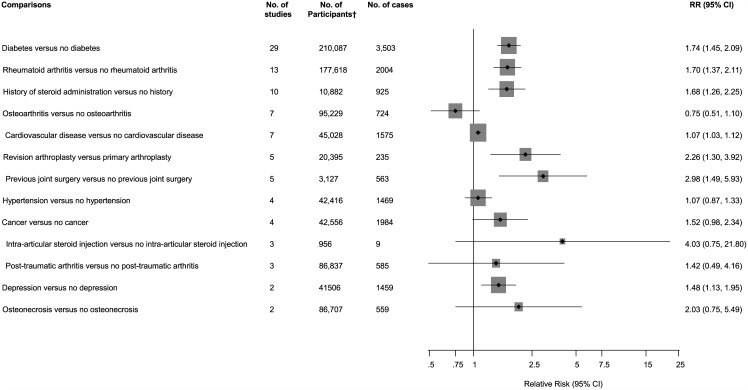
Medical and surgical history comparisons and risk of periprosthetic joint infection.CI, confidence interval (bars); RR, relative risk; †, are number of participants or arthroplasties.